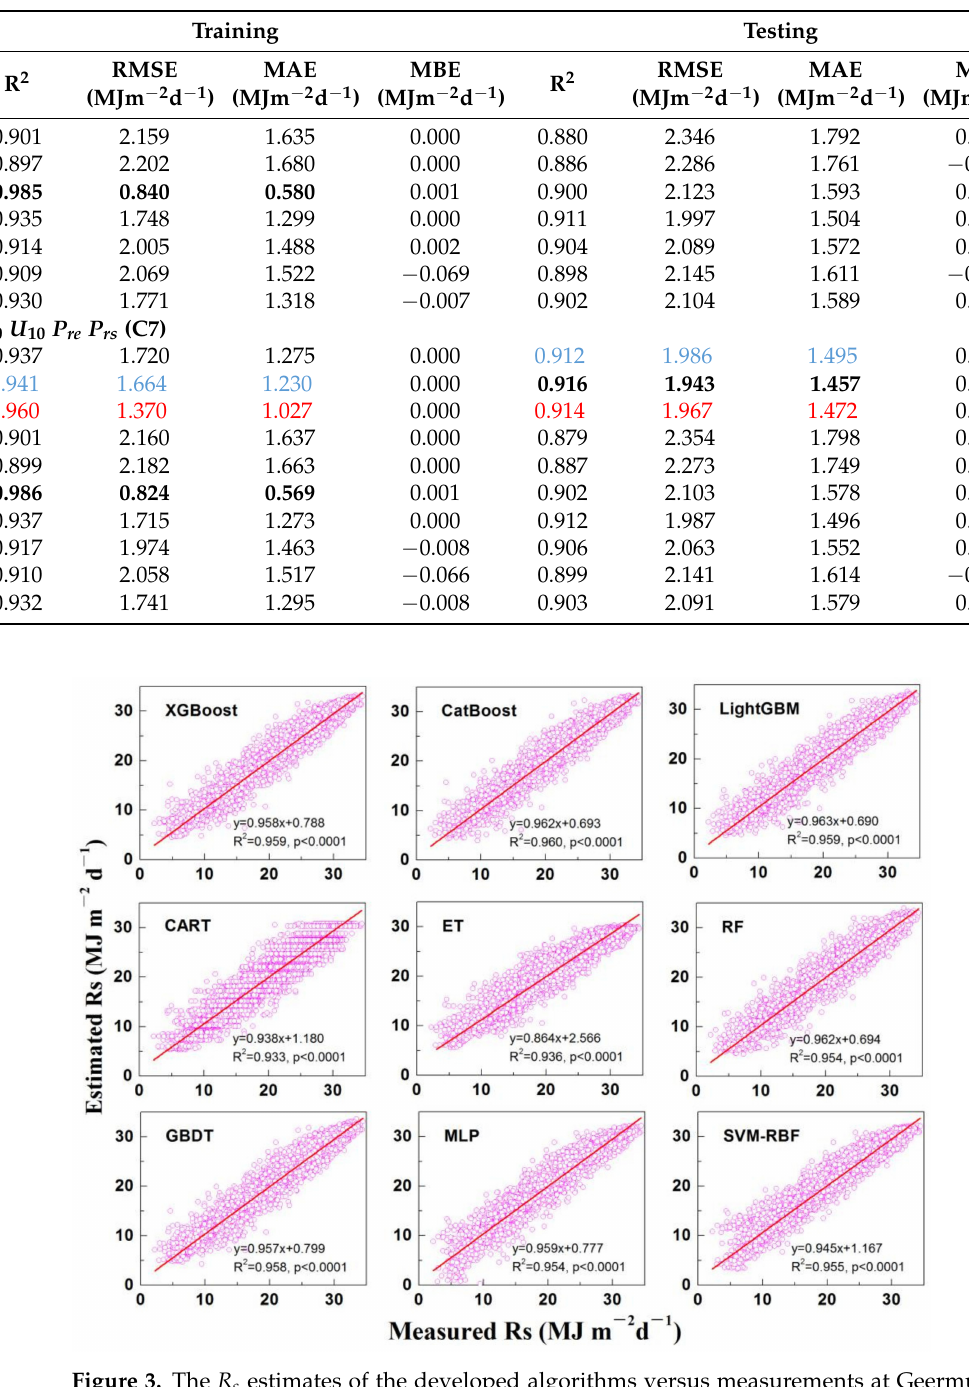
Figure 3. The R s estimates of the developed algorithms versus measurements at Geermu station under complete input